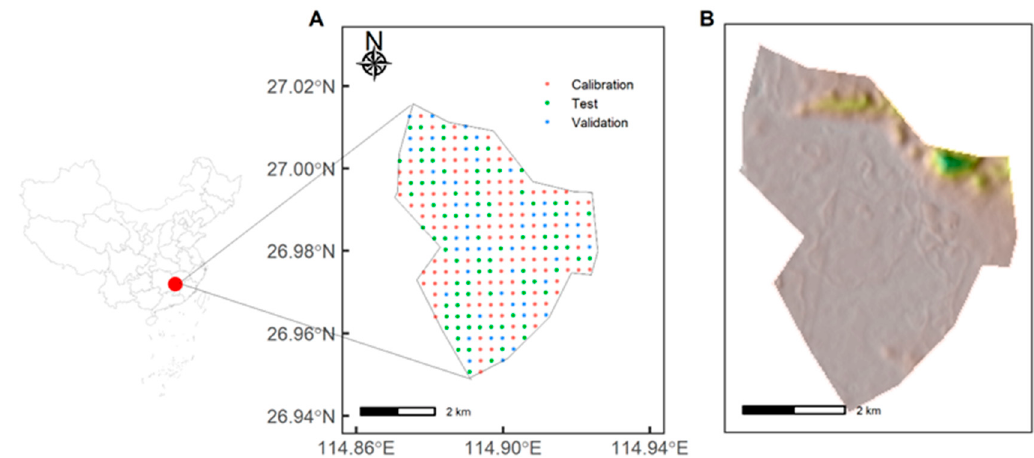
Figure 1. The location of sampling ( A ) and the DEM of the sampling location ( B ).